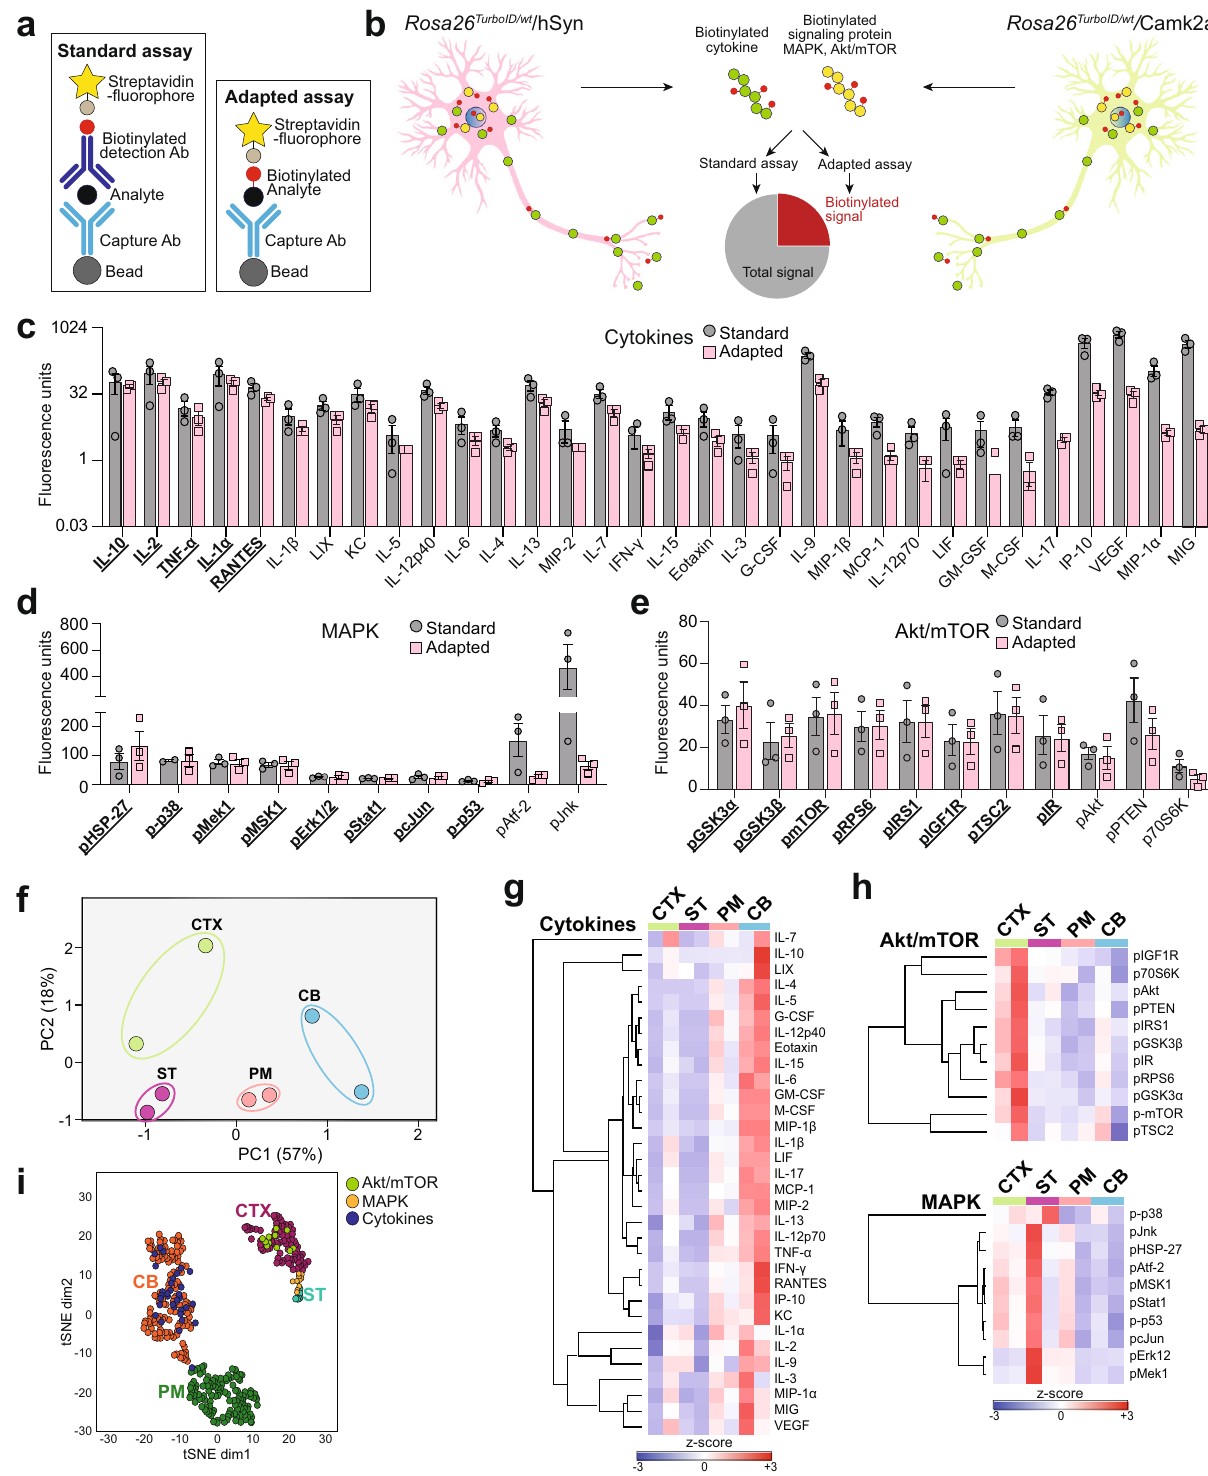
transgenic cohorts (Fig. 4b). First, we captured the proteins of interest onto beads using target-speci fi c antibodies, then a second biotinylated detection antibody followed by a streptavidin fl uor- ophore and fl uorescence quantitation (Fig. 4a, standard assay). In parallel, we adapted this assay to exclude the second biotinylated detection antibody to directly detect neuronal biotinylated proteins of interest via streptavidin fl uorophore (Fig. 4a, adapted assay). This provided an estimate of total (standard assay) and